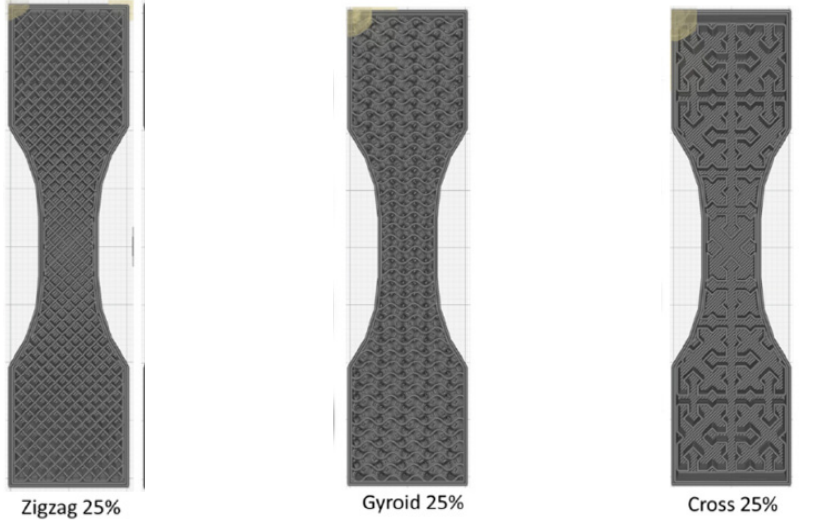
Figure 26. Three different tensile specimen patterns (zigzag, gyro, and cross) with 25% infill density [167].